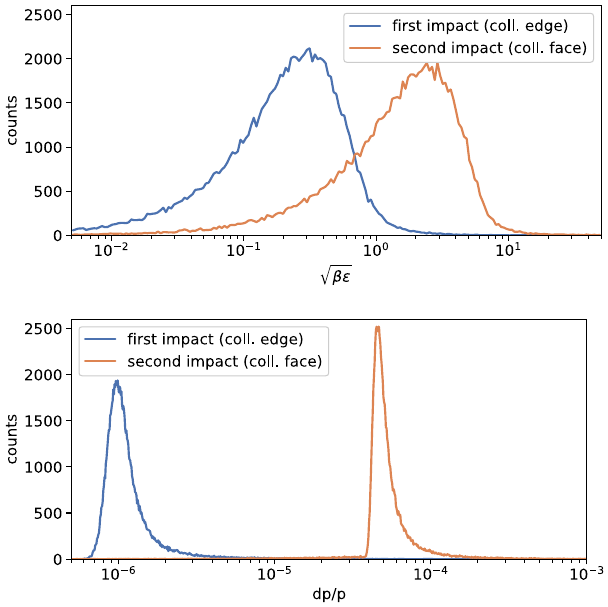
FIG. 4. Histograms of betatron amplitude increase (top) and relative momentum loss (bottom) of protons passing through the primary stage. Please note the logarithmic horizontal scale of both plots.